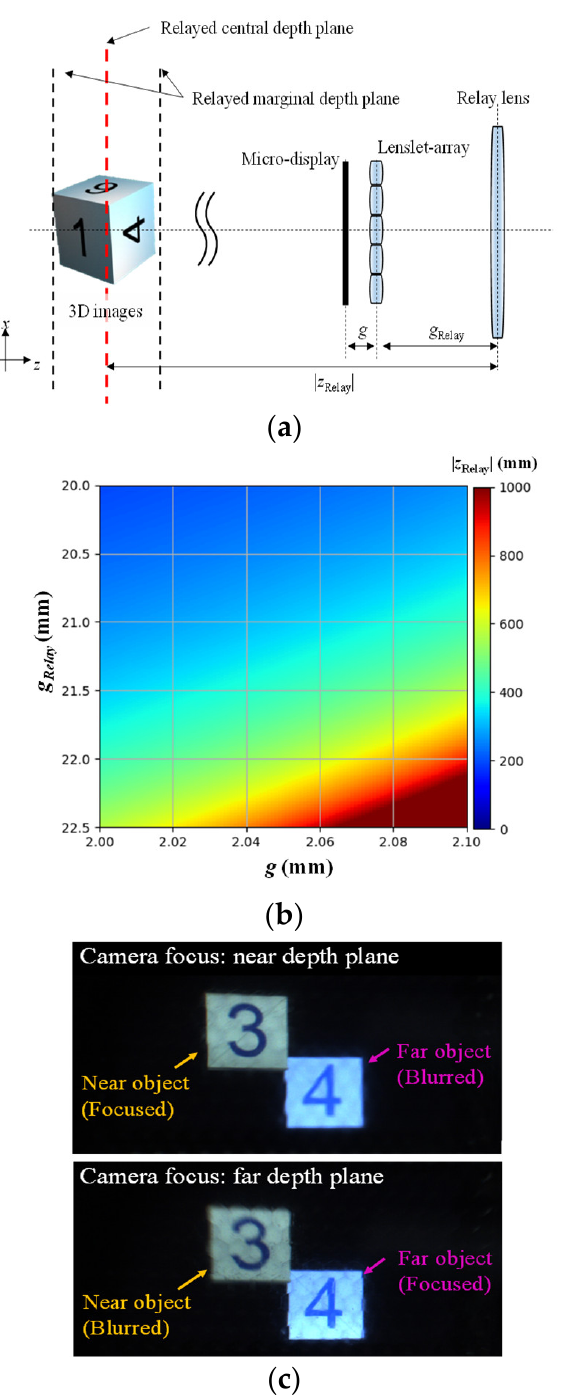
Figure 10. The design parameters and depth representation properties of implemented InIm system: ( a ) the geometry of InIm system with the relayed CDP, ( b ) the simulated variation of |z Relay | according to the gap parameters in the InIm, and ( c ) the captured images for the relayed InIm system with the different camera